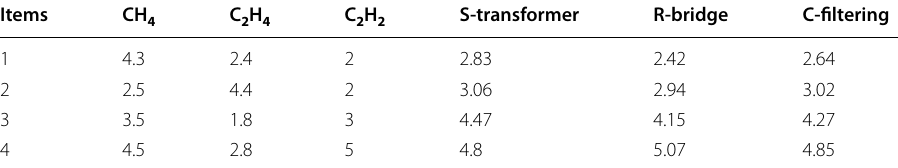
Table 5 The diagnostic effect of the fault diagnosis system model on the transformer Items